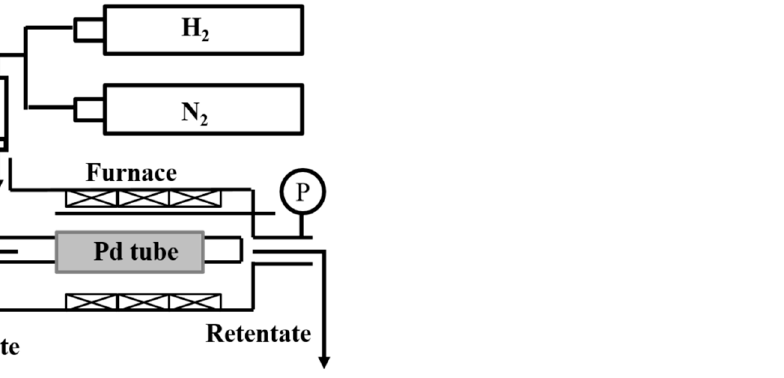
Figure 2. The homemade permeation-measuring module for pure hydrogen and nitrogen permea- tion measurements.